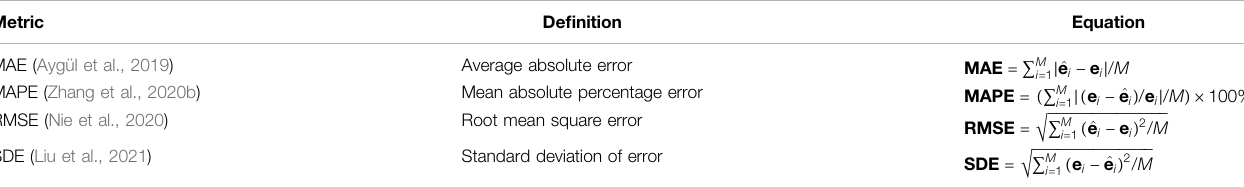
TABLE 2 | Four performance indicators.